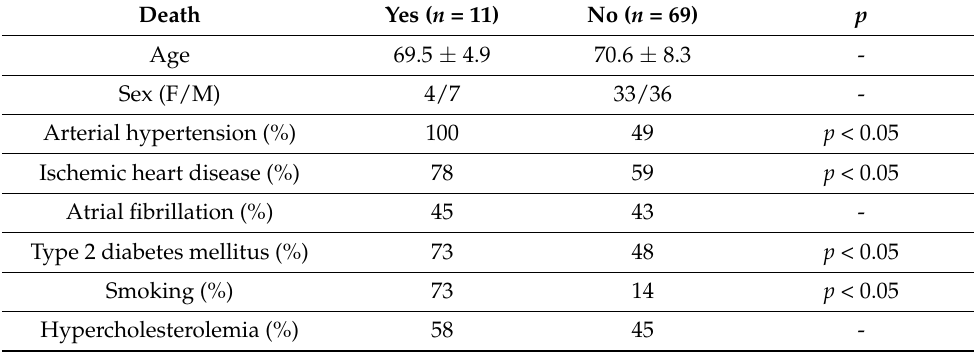
Table 3. Risk factors for ischemic stroke and post-stroke